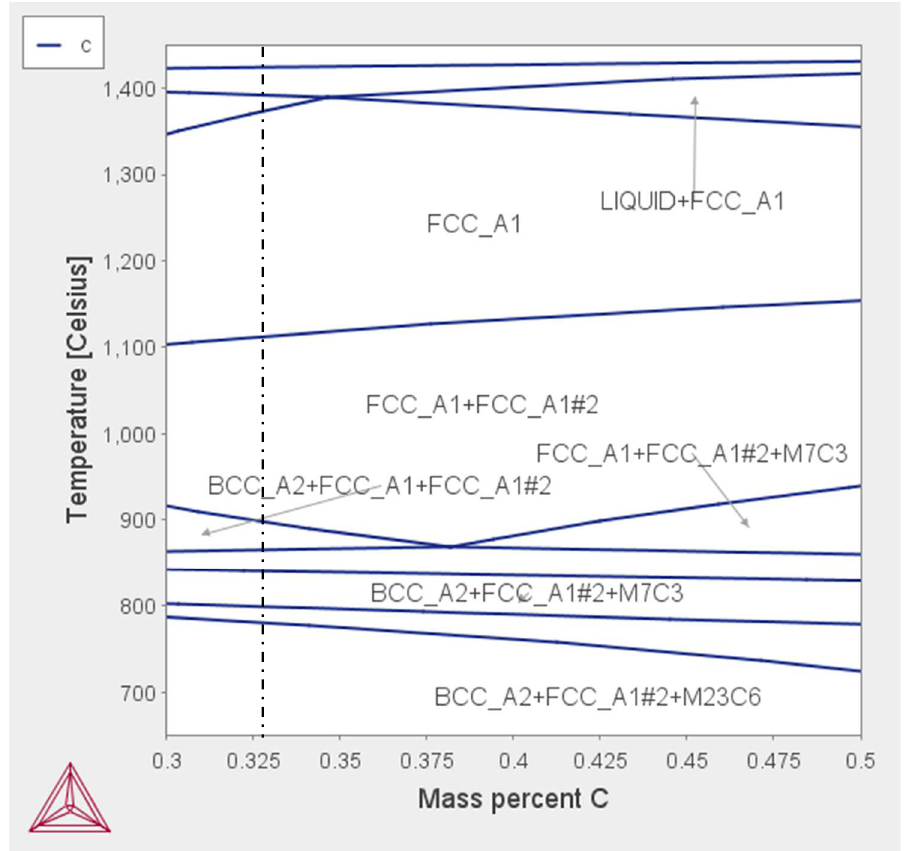
Figure 3: Phase diagram for the AISI H13 alloy (Thermocalc(r) software) according to the carbon content (wt.%). The dashed line indicates the composition of the samples processed in this